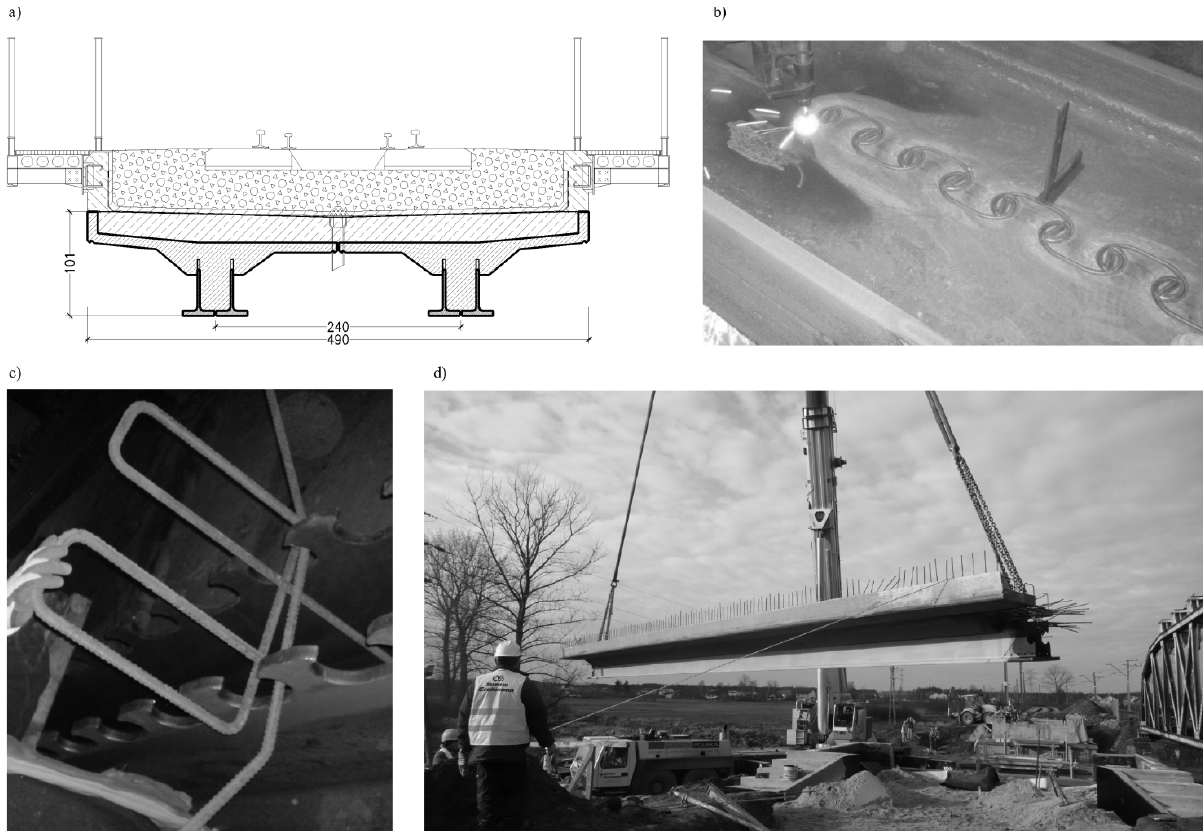
Figure 37: First railway bridge with composite dowel shear connection: a) cross section; b) fabrication of a clothoidal-shaped dowel cutting line substituting the cutting line presented in Fig. 29a; c) basic reinforcement forming composite dowels; and d) a prefabricated composite beam girder lifted by a crane